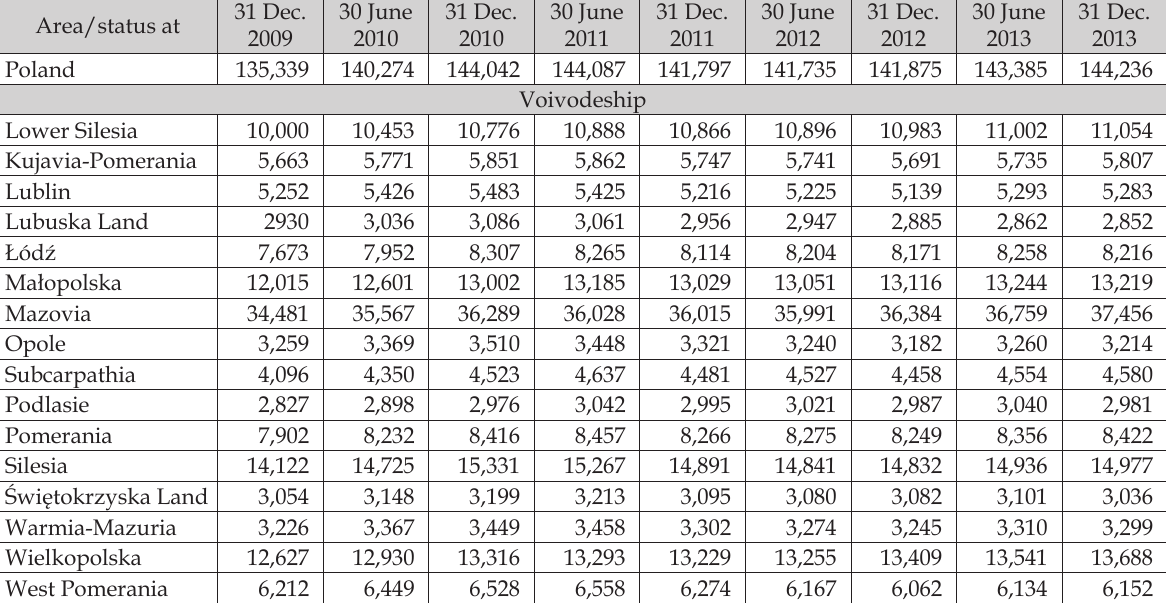
Table 2. Number of entities of the creative sector entered into the REGON register in the years 2009–2013. 31 Dec. Area/status at